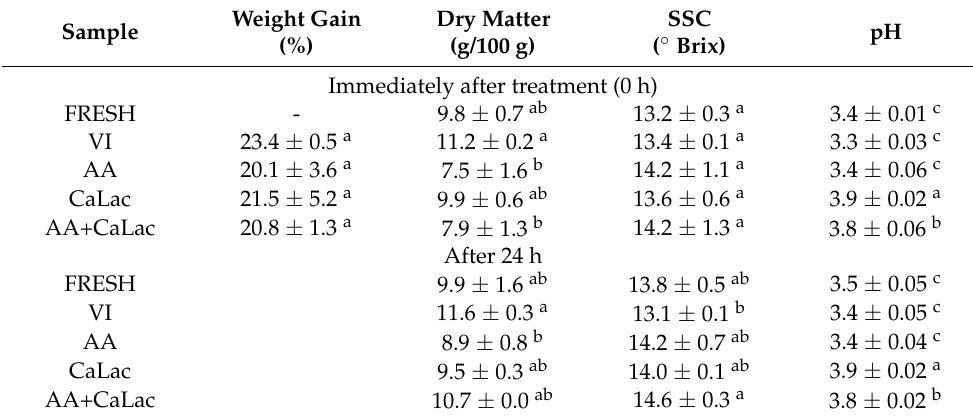
Table 3. Physico-chemical parameters of the vacuum-impregnated samples immediately after the vacuum impregnation (VI) treatment and after 24 h